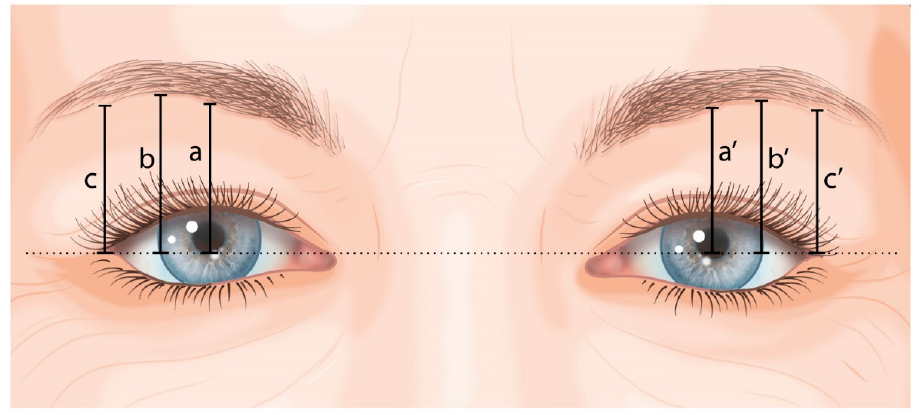
Figure 2. Eyebrow height measurements.